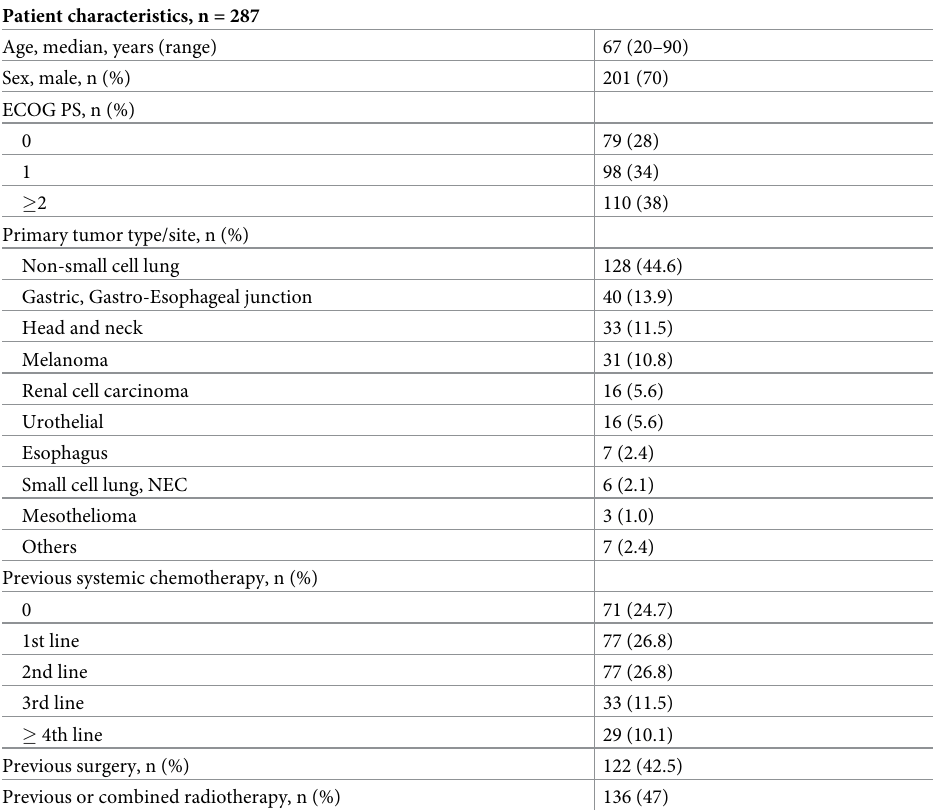
Table 1. Baseline characteristics of the patients in the